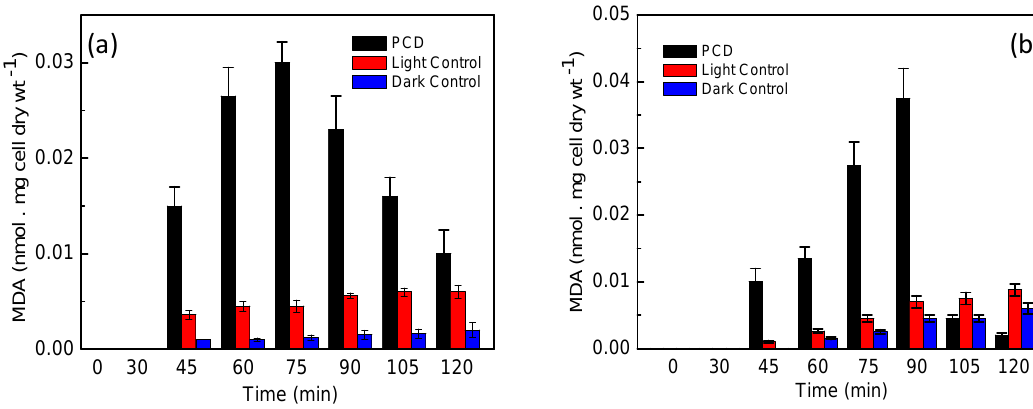
Figure 6. Lipid peroxidation kinetics of ( a ) E. coli and ( b ) S. aureus cells subjected to solar-photocatalysis in presence of 2 mg/L and 3 mg/L Ag@ZnO NPs respectively. Initial bacteria concentration = 5 × 10 6 CFU/mL, Temperature = 35 ± 2 °C. Error bars indicate the standard deviation of replicates ( n = 3).